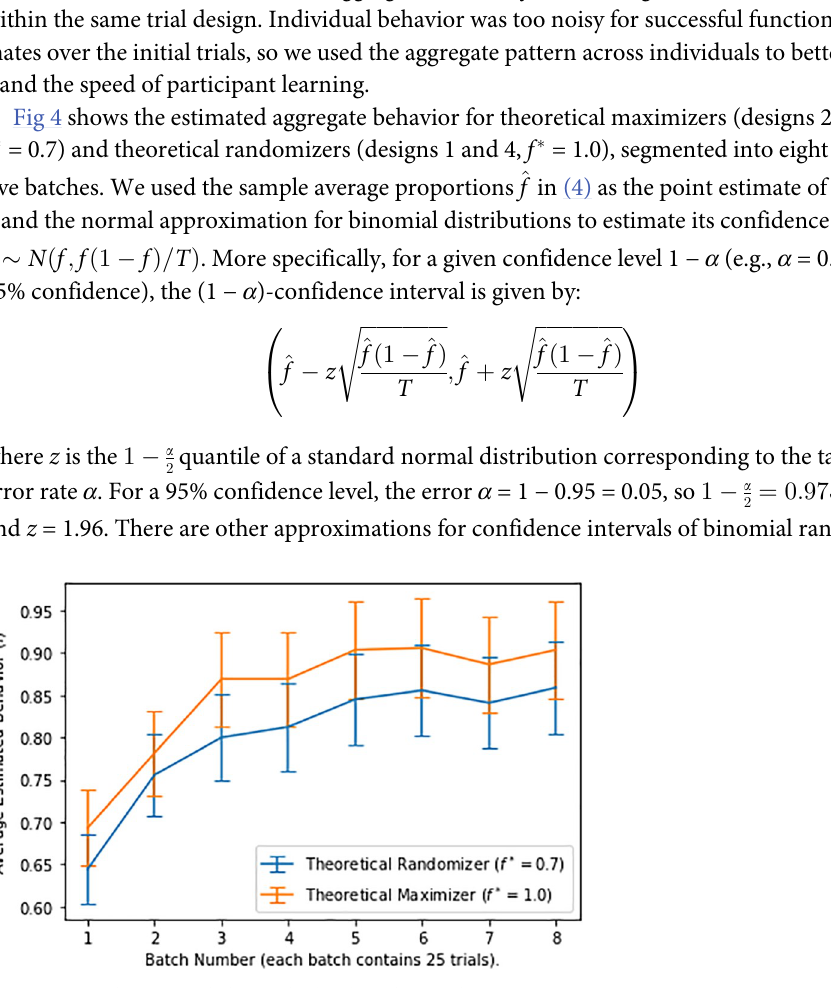
Fig 4. Estimated aggregate behavior for batches of 25-trial